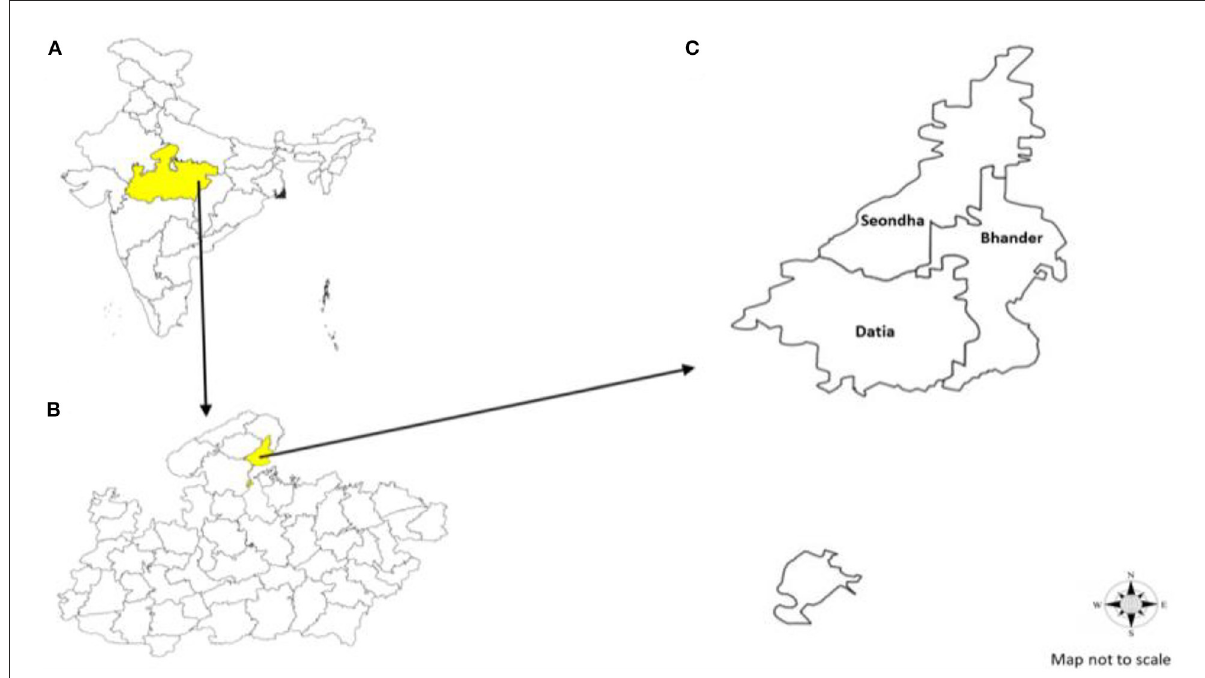
FIGURE1 (A) Map of India highlighting Madhya Pradesh State. (B) Map of Madhya Pradesh highlighting Datia District. (C) Map of Datia District with administrative blocks of the